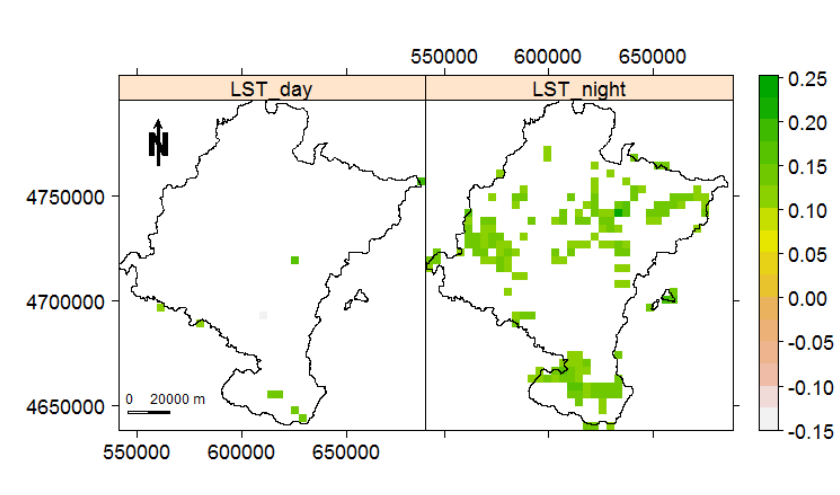
Figure 13. Detected pixels with significant trends based on univariate Mann–Kendall at significance level 0.01 for remote sensing LST data of Navarre, Spain, from January 2001 to December 2018. The scale on the right gives Kendall’s τ , for which positive values represent an upward trend, whereas negative values stand for downward